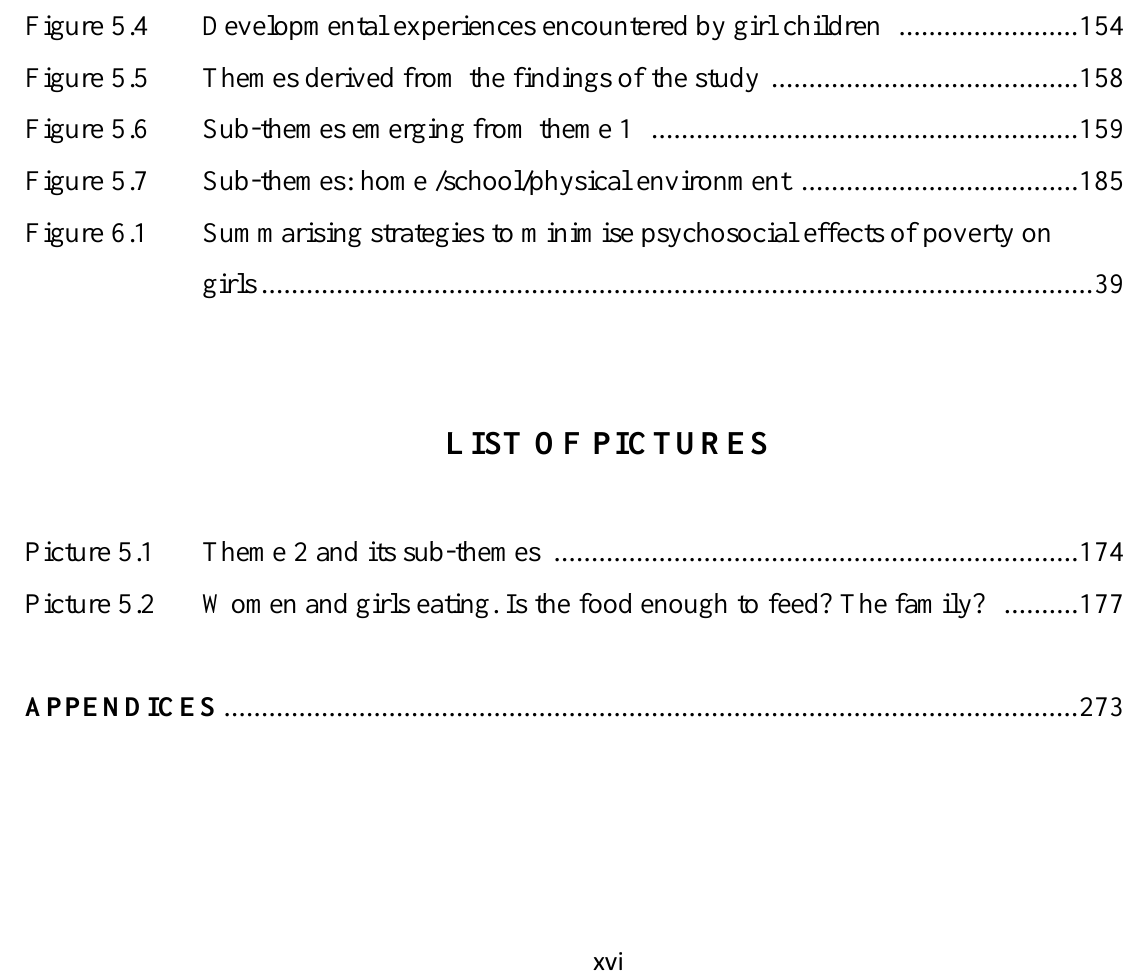
Figure 2.1 Figure 2.2 Figure 3.1 Figure 4.1 Figure 4.2 Figure 5.1 Figure 5.2 Figure 5.3 Figure 5.4 Figure 5.5 Figure 5.6 Figure 5.7 Figure 6.1 Summarising strategies to minimise psychosocial effects of poverty on